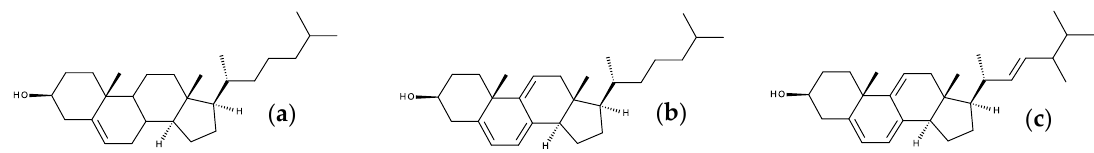
Figure 11. Structures of ( a ) Chol and intrinsically fluorescent triene sterols cholestatrienol (CTL, b ) and dehydroegosterol (DHE, c ).